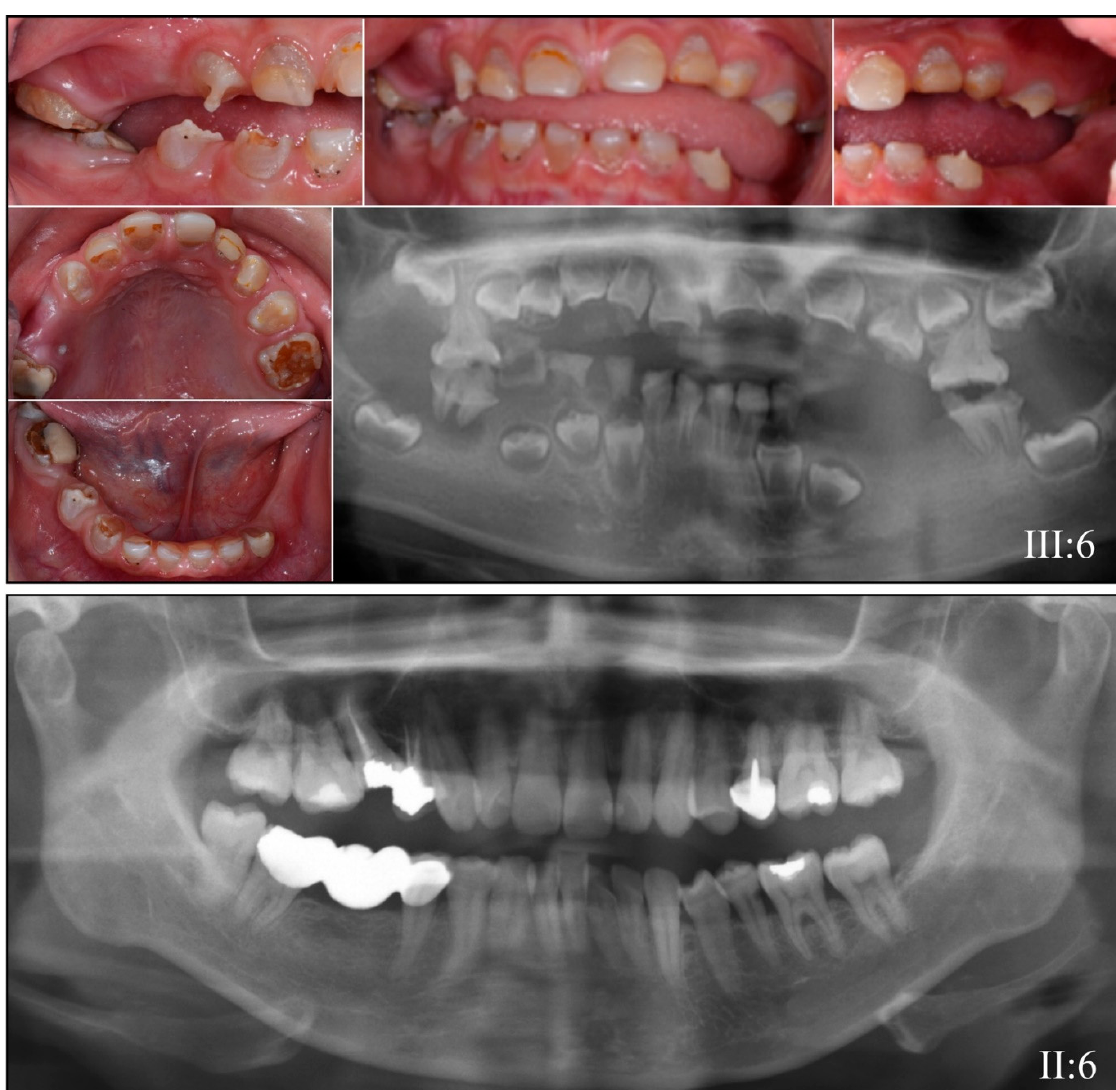
Figure 2. Family 1 from Taiwan with a DSPP c.50C>T; p.(Pro17Leu) defect. Top : Affected younger brother (III:6). His radiograph was taken at 8-years 4-months. His photos were taken 10-years 9-months. Bottom : Panoramic radiograph of the unaffected mother (II:6) at age 38-years.